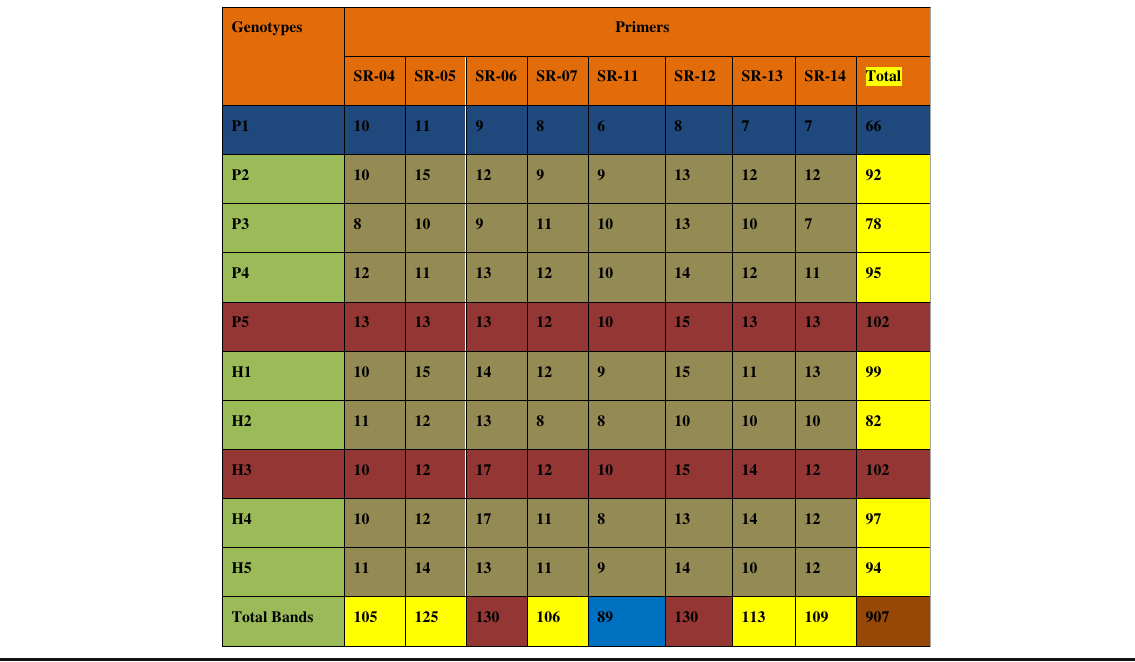
Table 11 Total bands produced from each primer for 10 sorghum genotypes and all amplified fragments in each genotype